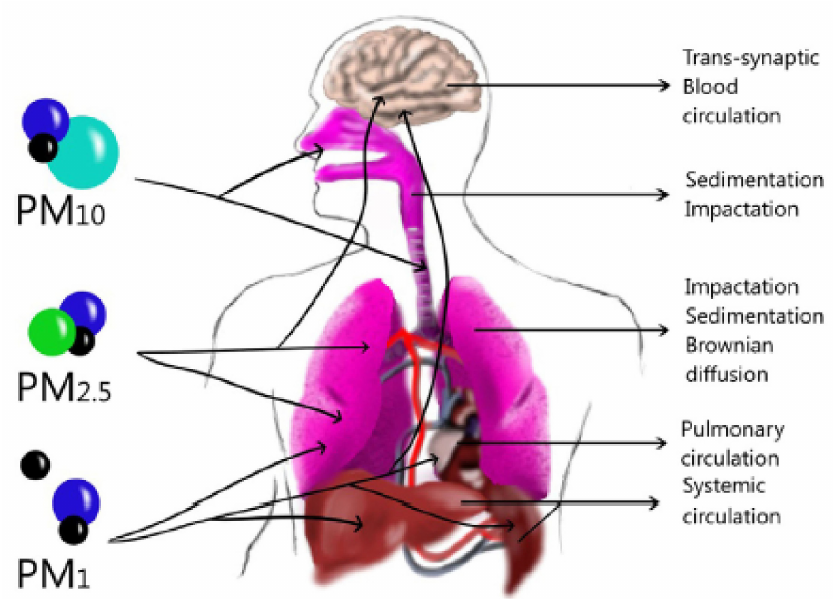
Figure 1. The size and dynamics of particulate matter (PM)in the lungs and others tissues